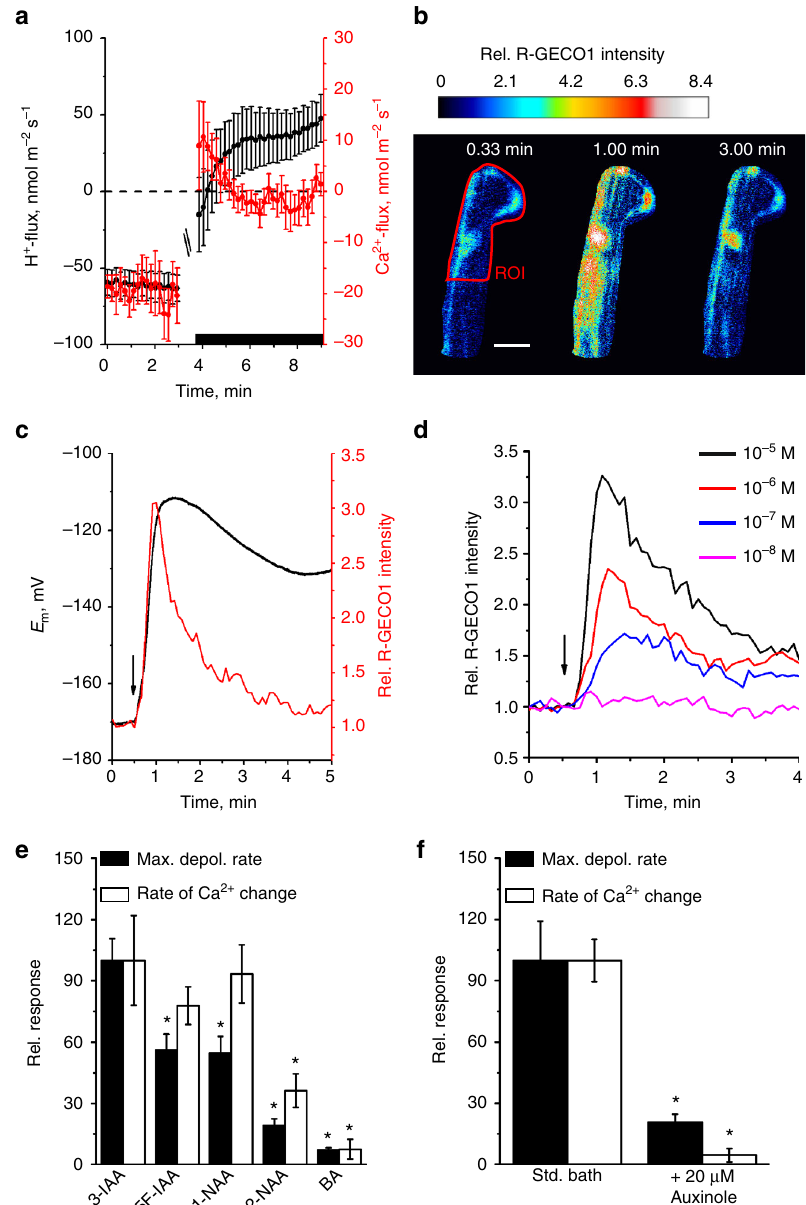
Fig. 3 Auxin induces Ca 2 + -in fl ux and increase of the cytosolic-free Ca 2 + -concentration of root-hair cells. a Average ion fl ux kinetics determined with ion- selective electrodes (H + black symbols, left axis; Ca 2 + red symbols, right axis, n = 12 ± s.e.m.). After 3 min, IAA was applied to a fi nal concentration of 10 µ M (black bar, curves are interrupted at time point of application). b IAA-evoked changes of the cytosolic-free Ca 2 + -concentration in root-hair cells, determined with R-GECO1. Images of a single root-hair cell, before, during, and after the application of 10 µ M IAA. IAA was applied at t = 0.5 min. False colored images indicate R-GECO1 fl uorescence intensity, relative to the average value in ROI (red line) just before IAA application (color code above the panels). The scale bar represents 20 µ m. c Simultaneous measurement of IAA-induced depolarization (black trace, left axes) and change in R-GECO1 fl uorescence intensity (red trace, right axes) of a ROI that includes the nucleus, in a single root-hair cell (arrow: time point of 1 s application of 10 µ M IAA). Representative measurement from 26 experiments. d IAA-dependent changes in R-GECO1 fl uorescence intensity determined across the root and representative of 7 experiments for each IAA concentration (indicated by colored lines). e Max. depolarization rate (closed bars) and slope of R-GECO1 intensity change (open bars) of single root-hair cells to 1 s pulses of 10 µ M IAA and auxin analogs, as indicated. Data are given as percentage of the response to 3-IAA ( n = 8 ± s.e.m. for BA and n = 16 ± s.e.m. for auxins), asterisks indicate signi fi cant reductions (Students t -test, p < 0.05). f Max. depolarization rate (closed bars) and slope of R-GECO1 intensity change (open bars) of single root-hair cells to a 1 s pulses of 10 µ M IAA. Root-hair cells were measured under control conditions, or after 20 min pretreatment with 20 µ M auxinole. Bars represent percentage of control ( n = 10 ± s.e.m. for control and 11 ± s.e.m. for auxinole), asterisks indicate signi fi cant reductions (Students t -test, p <